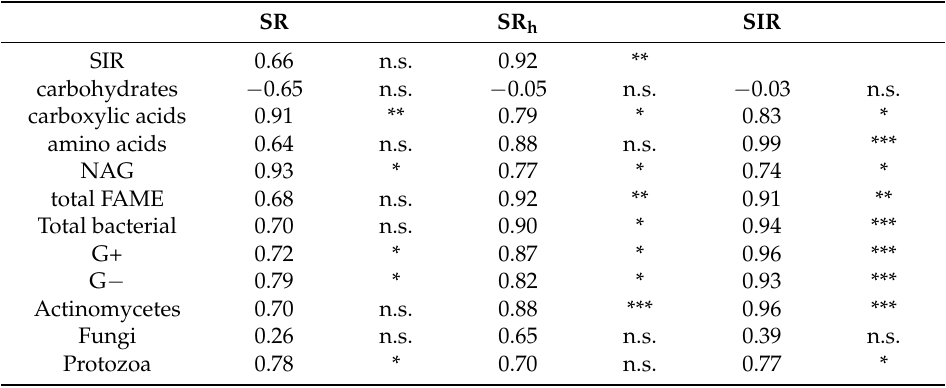
Table 4. Pearson coefficients of correlation between SR and SR h with SIR and EL-FAME parameters.